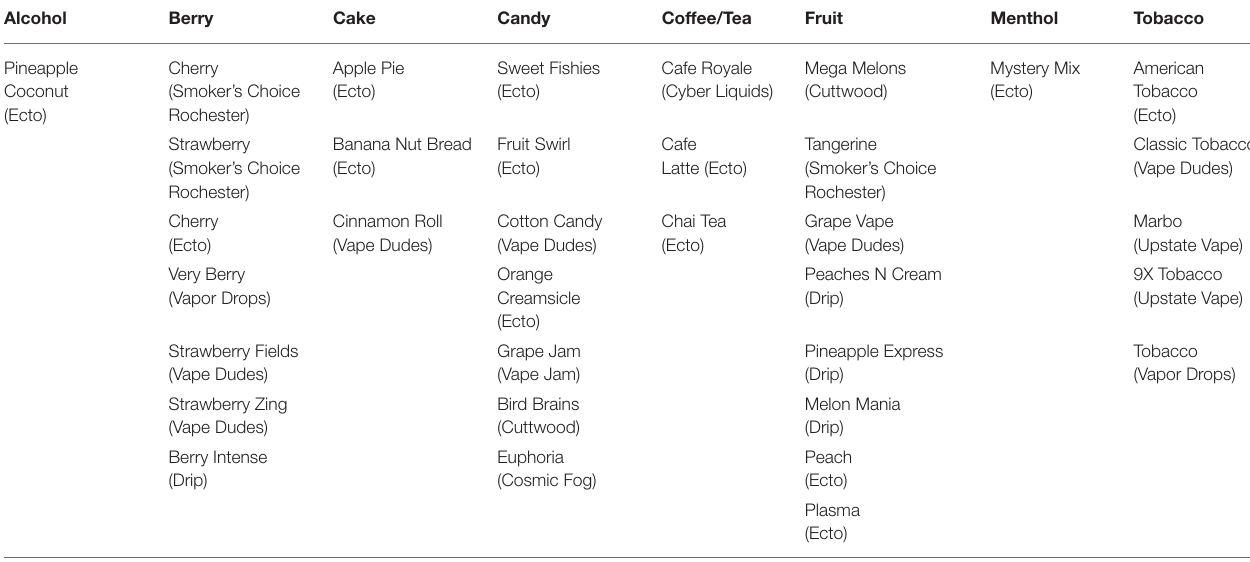
TABLE 1 | Categorization of e-liquids by flavor*. Alcohol Berry Cake Pineapple